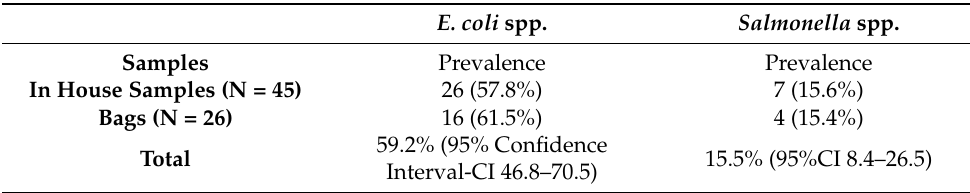
Table 2. Prevalence of E. coli and Salmonella spp. in 71 poultry litter